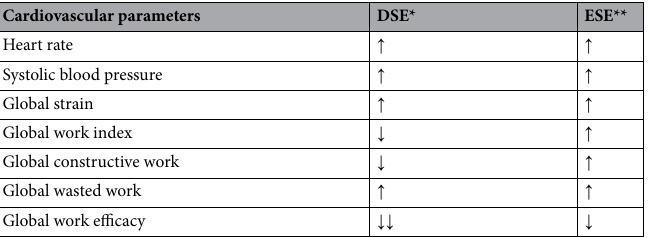
Table 3. Cardiac effects of dobutamine and exercise stress echocardiography. DSE dobutamine stress echocardiography, ESE exercise stress echocardiography. *Data regarding DSE—current study. **Data regarding ESE—literature data Halabi et al. 23 , Borrie et al. 24